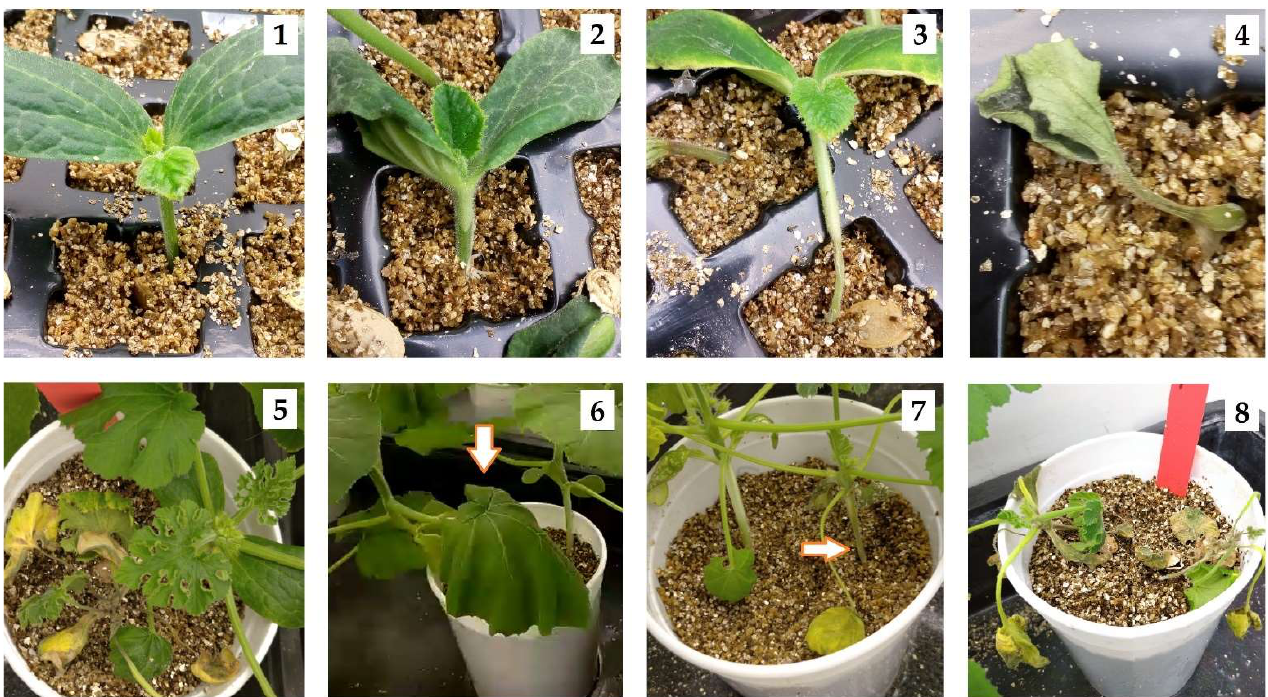
Figure 1. Tolerance screenings in the mutant population of MUCU-16. Screening with seedlings 14 days post-inoculation (dpi) ( 1 – 3 ): control tray (center) without inoculation ( 1 ); Fusarium solani f. sp. cucurbitae (left) and Phytophthora capsici (right) inoculated trays ( 2 ); individuals showing tolerance ( 3 ). Screening with selected plants ( 4 – 6 ): plant symptomatology 21 dpi—surviving individuals were moved to a greenhouse after 34 dpi and reinoculated ( 5 ); surviving plant growth until 97 dpi for fruit production ( 6 ).